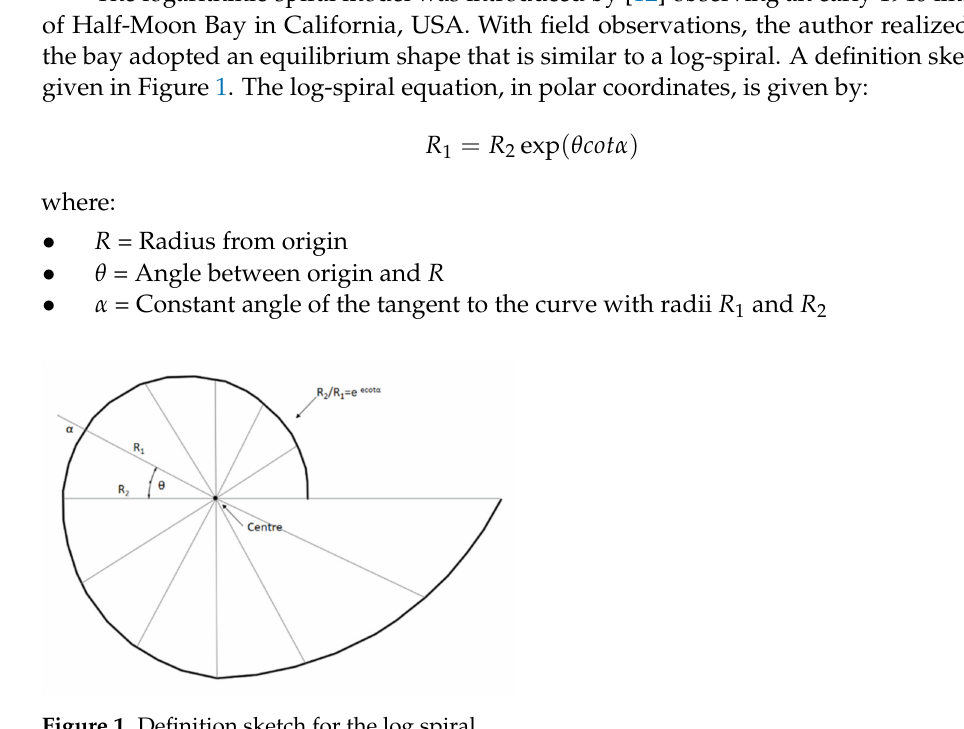
Figure 1. Definition sketch for the log